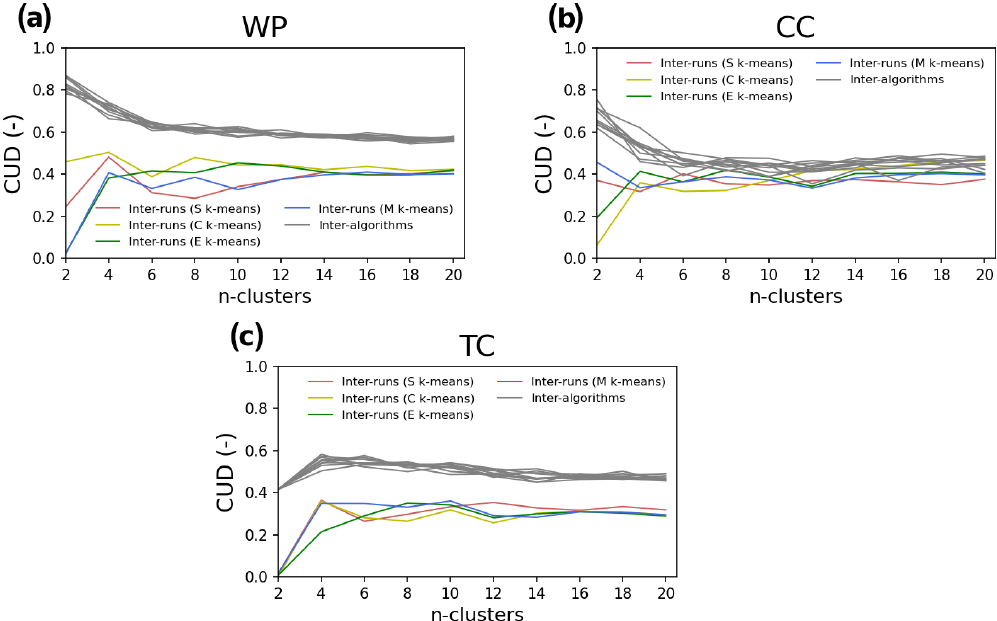
Figure 12. Clustering uncertainty degree (CUD) based on adjusted mutual information (AMI) between the clustering results from different runs (10 runs indicated by R0, R1, ..., R9) of different k -means algorithms, i.e., S, C, E, and M k -means (rows), for different demo experiments: WP, CC, and TC (columns). Note that the results are from the configuration k = 2 , 4 , ...,